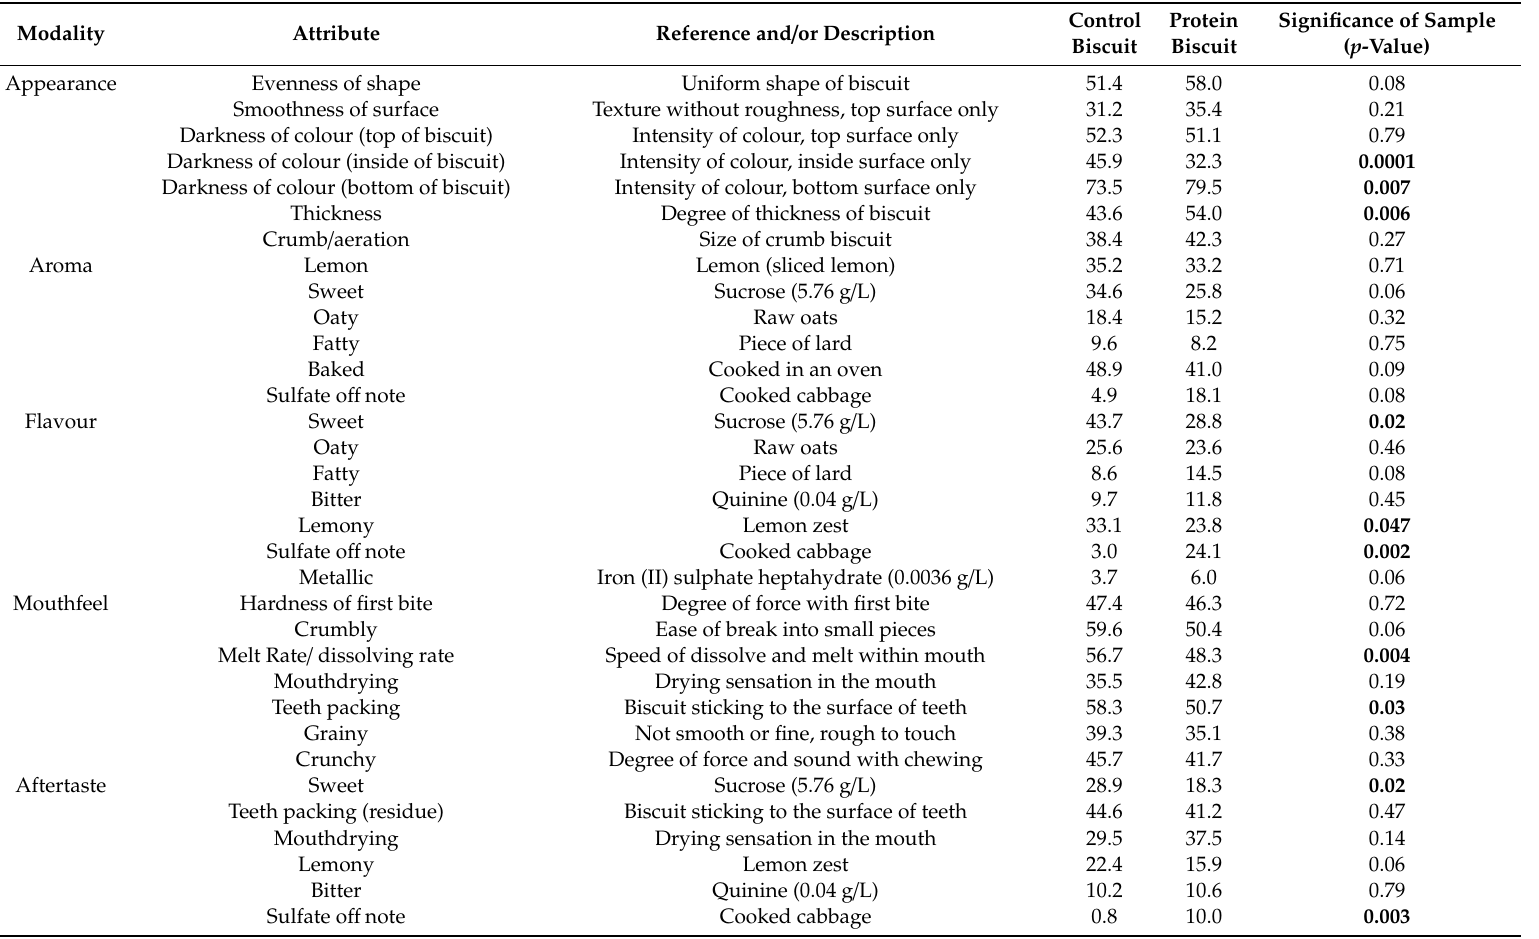
Table 3. Summary of sensory profile with corresponding reference / description and results for biscuits. Values are expressed as means (measured on a visual analogue scale (VAS,